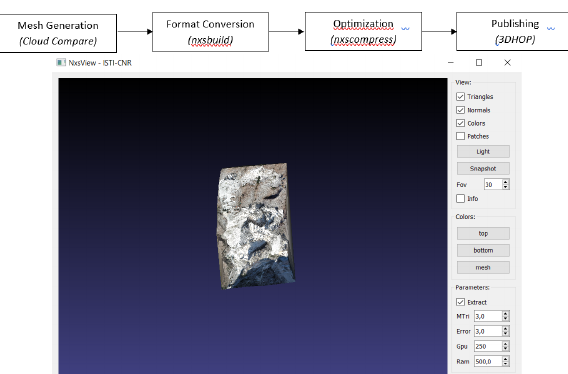
Figure 7 . Point clouds processing chain and final result in